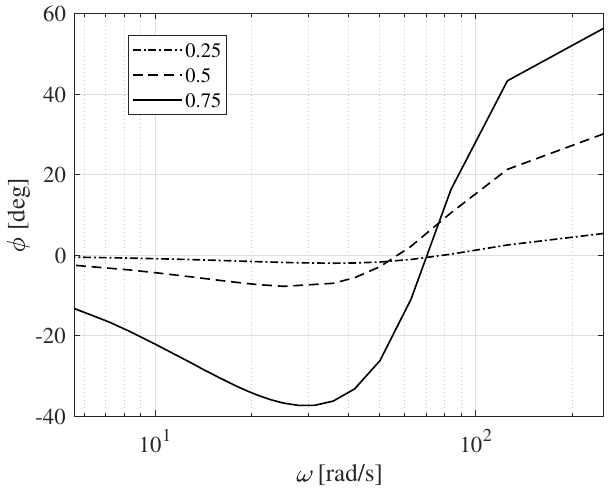
Figure 8. The Bode diagrams of magnitude and phase of FOPID using CFE.